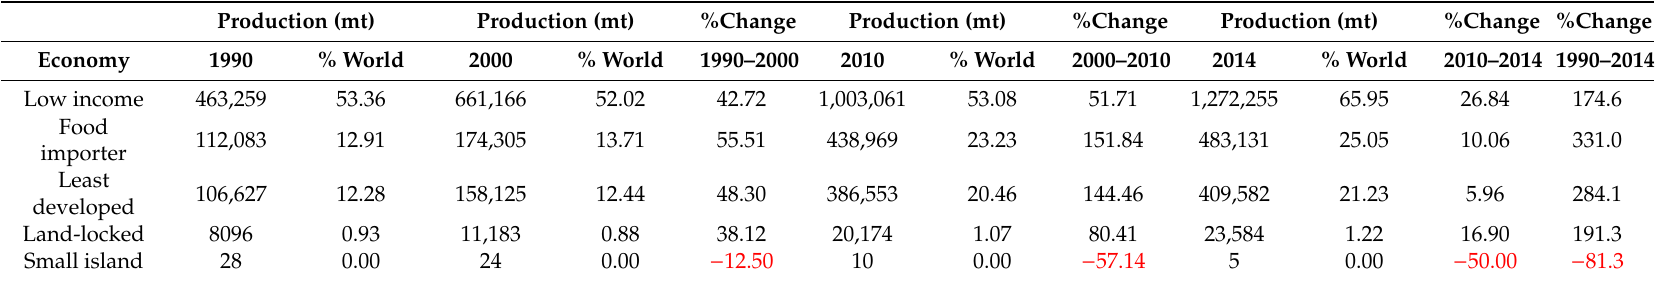
Table 3. Areca nut production by Asian economy,